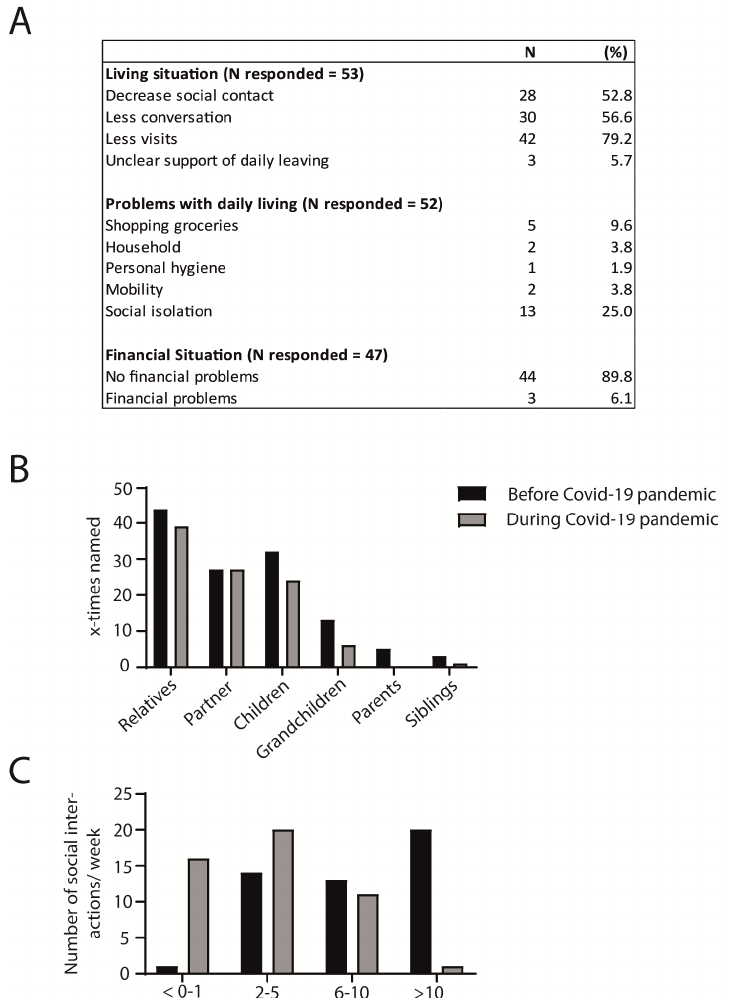
Figure 2. ( A ) Table depicting changes in daily living and in the financial situation due to the COVID-19 pandemic and lockdown measures. N responded = the number of callers who were willing to answer the question. N represents the number of callers who affirmed the specific information and features asked. ( B ) While the social interaction with one’s partner remained stable, callers reported fewer social interactions with all other relatives (including children, grandchildren, parents, and siblings) during the crisis. ( C ) The number of social interactions also decreased during the COVID-19 pandemic; while most participants had >10 social interactions in person per week before COVID-19, most callers reported a decrease in all personal social interactions to 2–5/week during the lockdown measures.